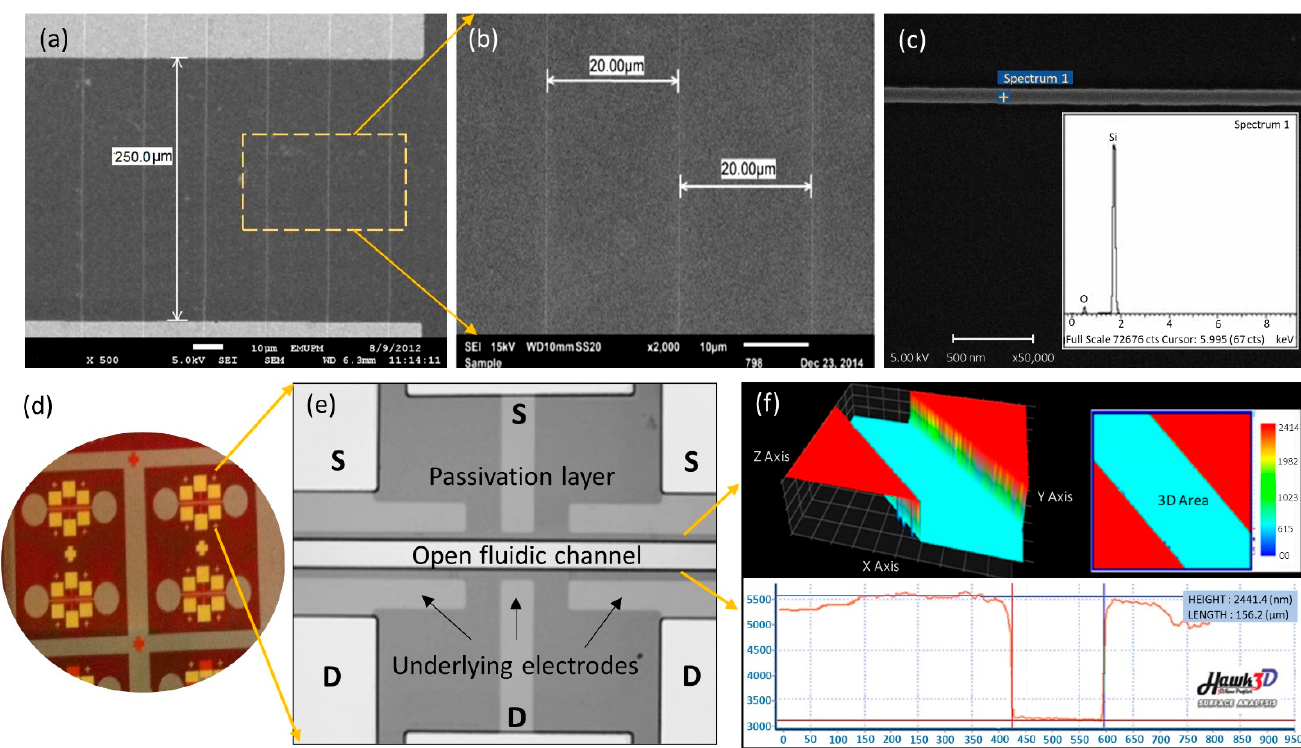
Figure 3. FESEM images of ( a ) SiNWs bridged a 250 µm gap of electrodes and ( b ) a 20 µm gap between SiNWs. ( c ) EDX analysis of nanowire surface. ( d – f ) The developed pattern of Mask 3 as a final device layout.